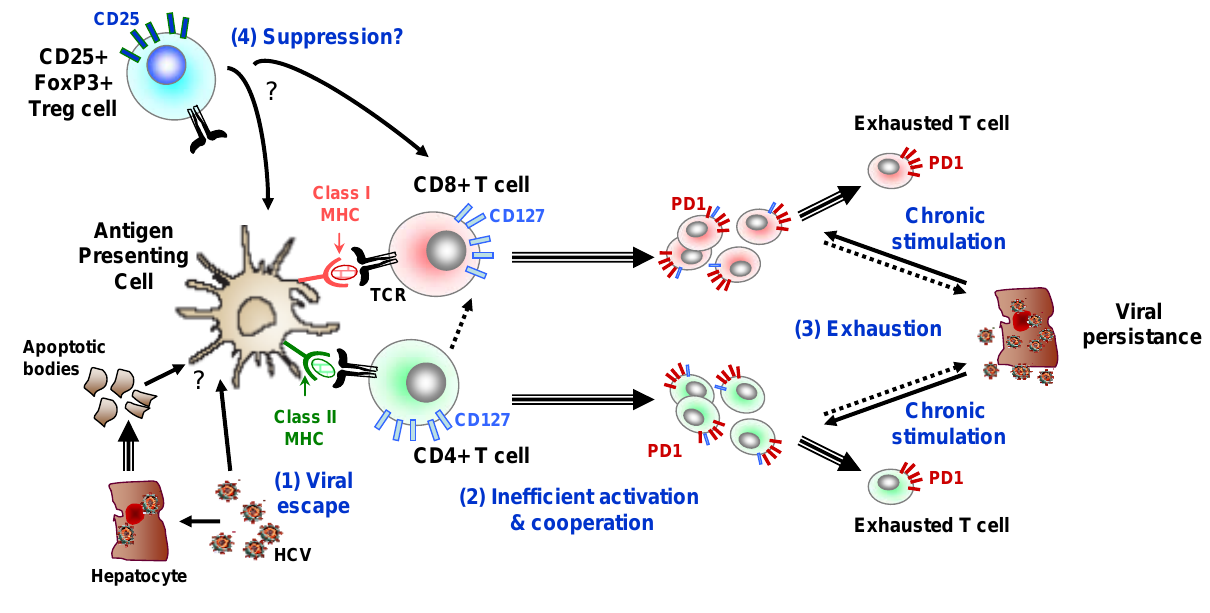
Figure 2. Examples of mechanisms resulting in impairment of T cell responses leading to chronic HCV infection. Chronic HCV infection is associated with impaired CD8+ T cell responses including reduced cytotoxic potential, reduced secretion of Th1 type cytokines and reduced proliferative capacity in response to ex vivo antigenic stimulation. Four possible mechanisms of T cell response failure are shown here: (1) viral escape with mutations in HLA restricted epitopes impairing antigen recognition, (2) loss of functional CD4+ T cell responses, (3) overexpression of PD1 in CD8+ T cells; when PD1 binds to its ligand PD-ligand 1 (PD-L1), which is preferentially expressed by virus-infected cells, an inhibitory signal is transmitted to CD8+ T cells, resulting in blocking of the T cell receptor-mediated activation signal, (4) induction of regulatory T cells. Arrows with single line indicate functional interactions while arrows with double lines indicate cell differentiation.